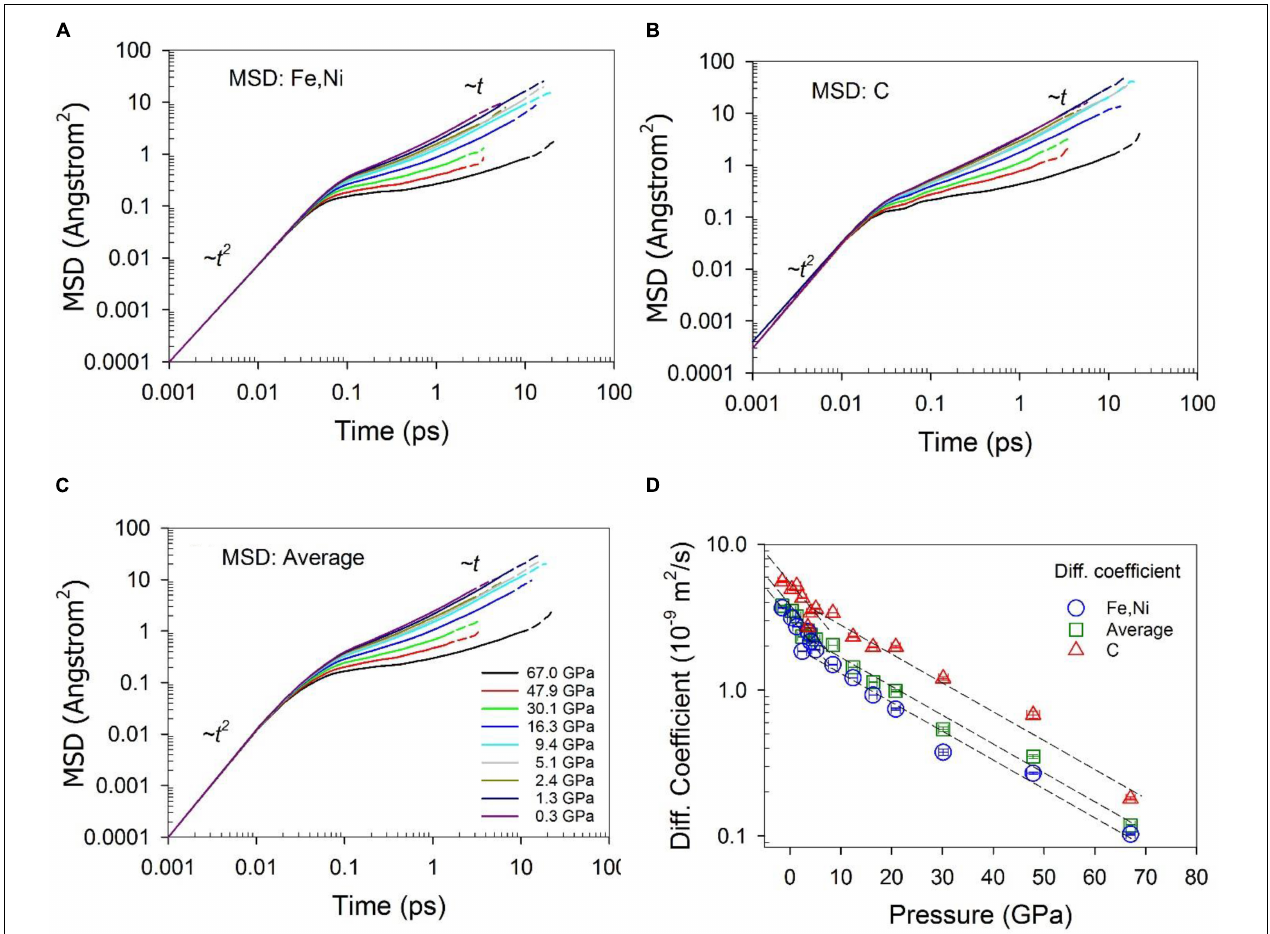
FIGURE 9 | Mean squared displacement – (A) Fe and Ni, (B) C, and (C) average, and (D) Self diffusion coefficient of Fe-Ni-C liquid at 1673 K and different pressures. The solid portion of the lines in (A–C) are calculated with half of the simulation time, and dashed lines are with the full simulation time. The dashed lines in (D) are to guide the eye. The error bars in pressure are one standard deviation of the average. The errors for diffusion coefficients are within the size of the symbol, as estimated from the MSD fitting and consideration of correlations in MD trajectories. The actual errors might be larger as indicated by the variability of the values.